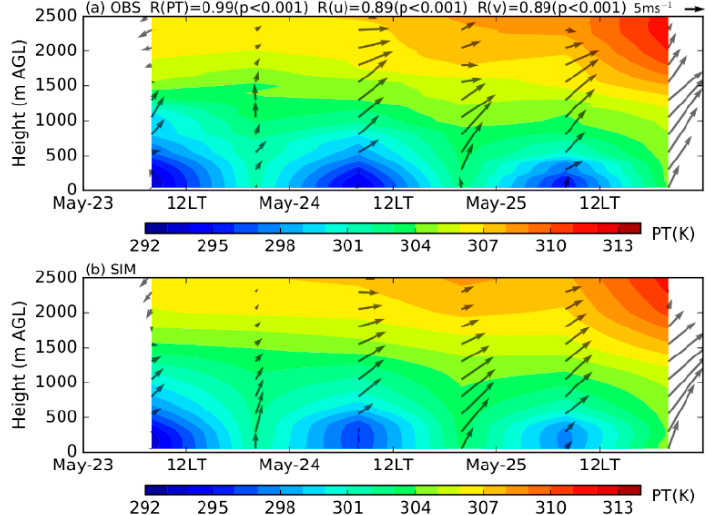
Figure 5. Vertical structures of ( a ) the observed and ( b ) the simulated PTs and horizontal winds in Beijing from 23 to 25 May, 2015. Both simulations and observations are shown with an interval of 12-h. At the top of Figure 5a, the correlation coefficients (R) between simulations and observations are presented. site in Beijing were simulated using the HYSPLIT. With a high pressure located over the south seas at the 925-hPa level, there was a southeast-to-northwest pressure gradient across Beijing from 23 to 25 May, which supported the southerly prevailing winds towards Beijing (Figure 6). Influenced by